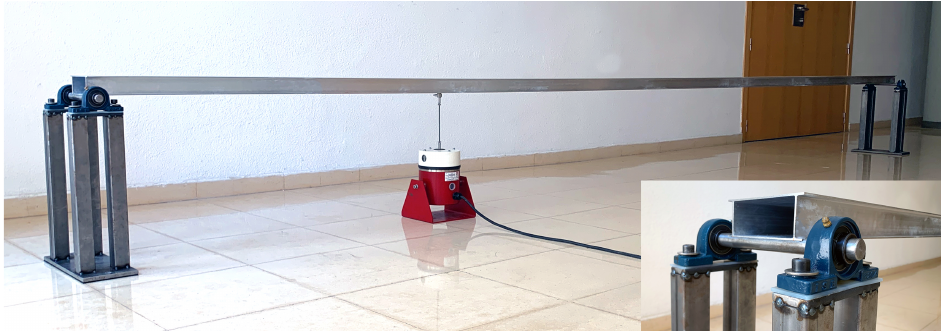
Figure 1. Pinned–pinned lightweight aluminium beam and detail of the